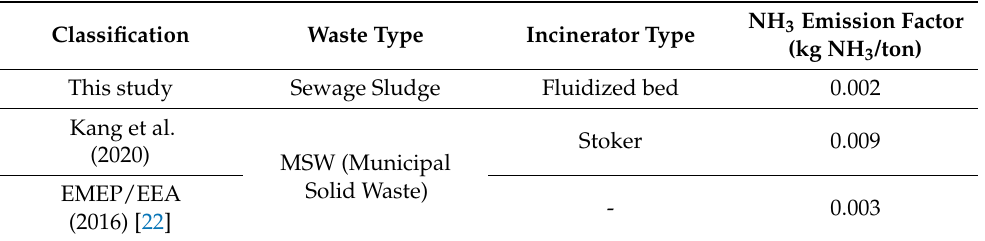
Table 3. Comparison of NH 3 emission factor at the waste incinerator.